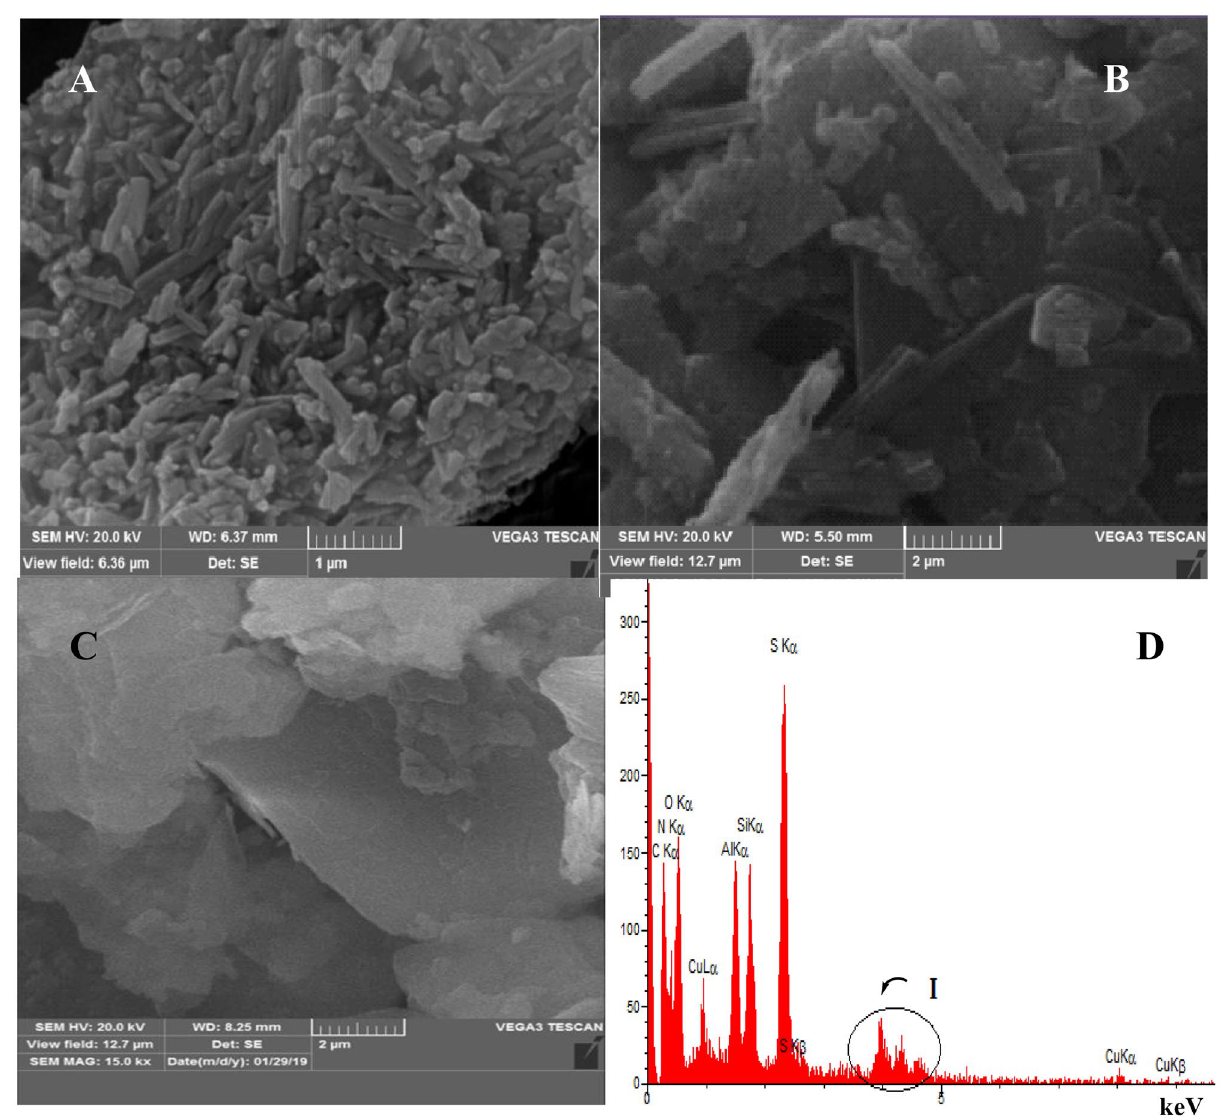
Figure 3. SEM images of ( A ) pure HNTs and ( B , C ) CuI@HNT-TSC-PC and ( D ) EDS analysis of CuI@HNT-